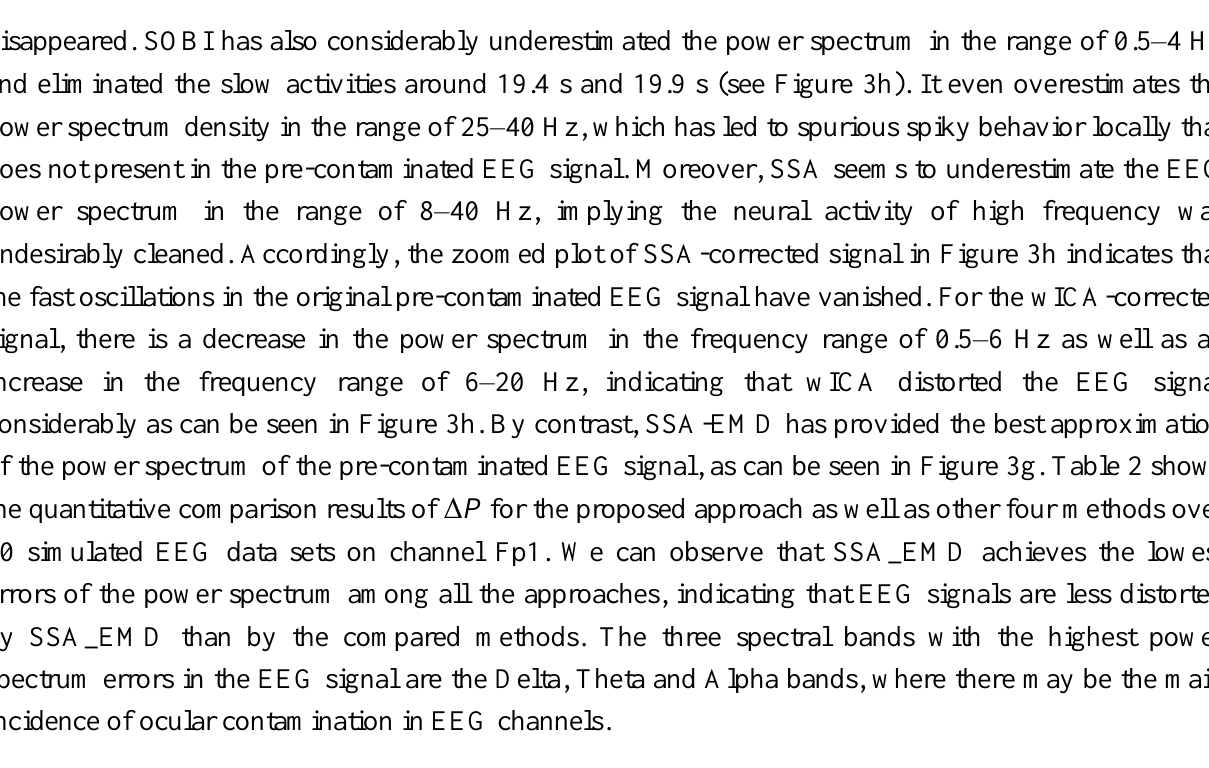
Table 2. MI and Δ P by different EOG artifact correction methods over 20 artificially contaminated EEG data sets on channel